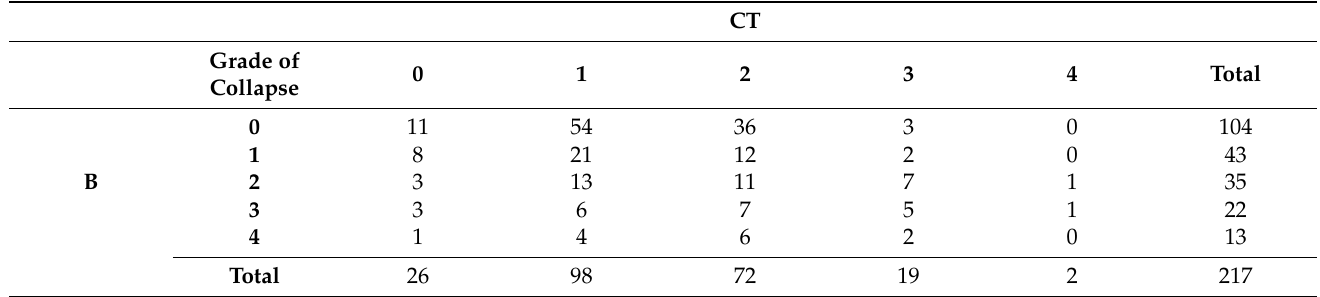
Table 6. Comparisons of scores for airway caliber narrowing using inspiratory/expiratory breath- hold CT and bronchoscopy (B) for the six lobar bronchi. The CT-determined percentage of dynamic airway wall narrowing based on dorsoventral diameter and subjective bronchoscopic narrowing were each used to assess a score (in bold) from 0–4 as shown in Table 1. Numbers which are not in bold reflect the number of airways evaluated for each grade of collapse for each imaging modality.